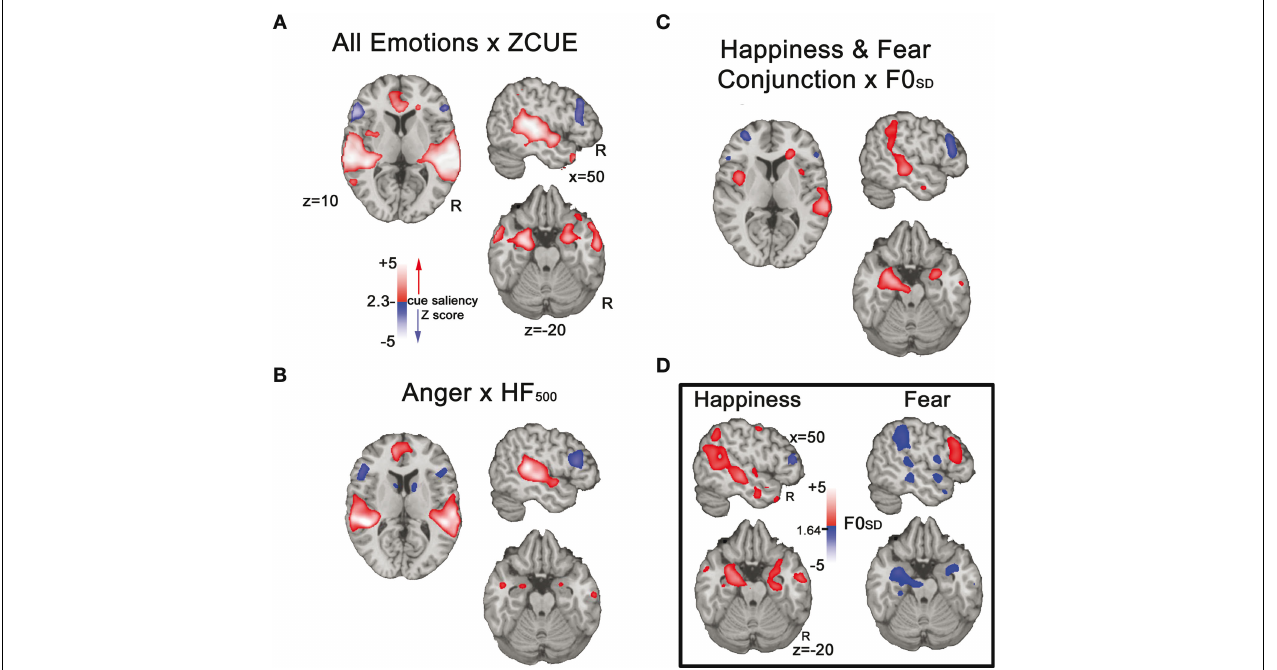
pattern. (D) Uncorrected p < 0.05 maps of F0 modulated activity for happy (left) SD and fear (right) indicate activation clusters spanning pSTG, amygdala and IFG. For happiness increasing F0 (red) is associated with activation increases in pSTG SD and amygdala while decreasing F0 (blue)is associated with increasing IFG SD increased/ activation. The reverse pattern is seen for fear, decreasing F0 is associated with 500 SD ) activation increases in pSTG and amygdala, while decreasing F0 is associated SD SD ) for fear yielded a similar with increasing IFG SD